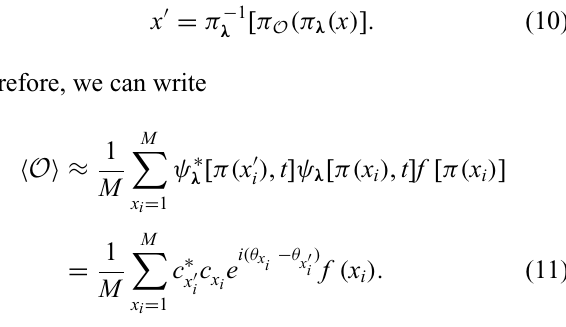
FIG. 1. The local random circuit architecture used throughout this paper. Each two-site gate is chosen randomly to be one of three basic automaton gates: the SWAP gate, the CNOT gate, or the single-site rotation about the z axis R z (θ) = e i θ ˆ Z (applied independently to each site with a random angle θ